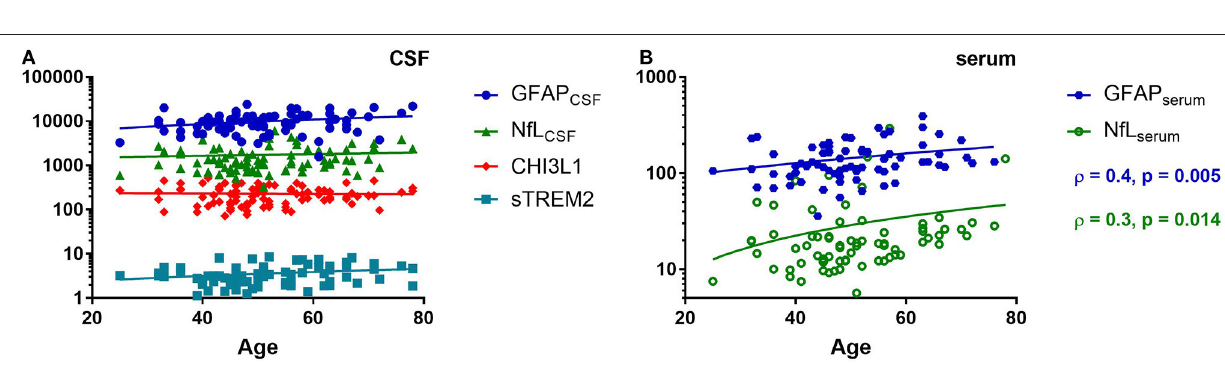
with sTREM2 ( ρ = 0.4, p < 0.01, Figure 7 ) but not with GFAP. On the other hand, GFAP did not correlate with